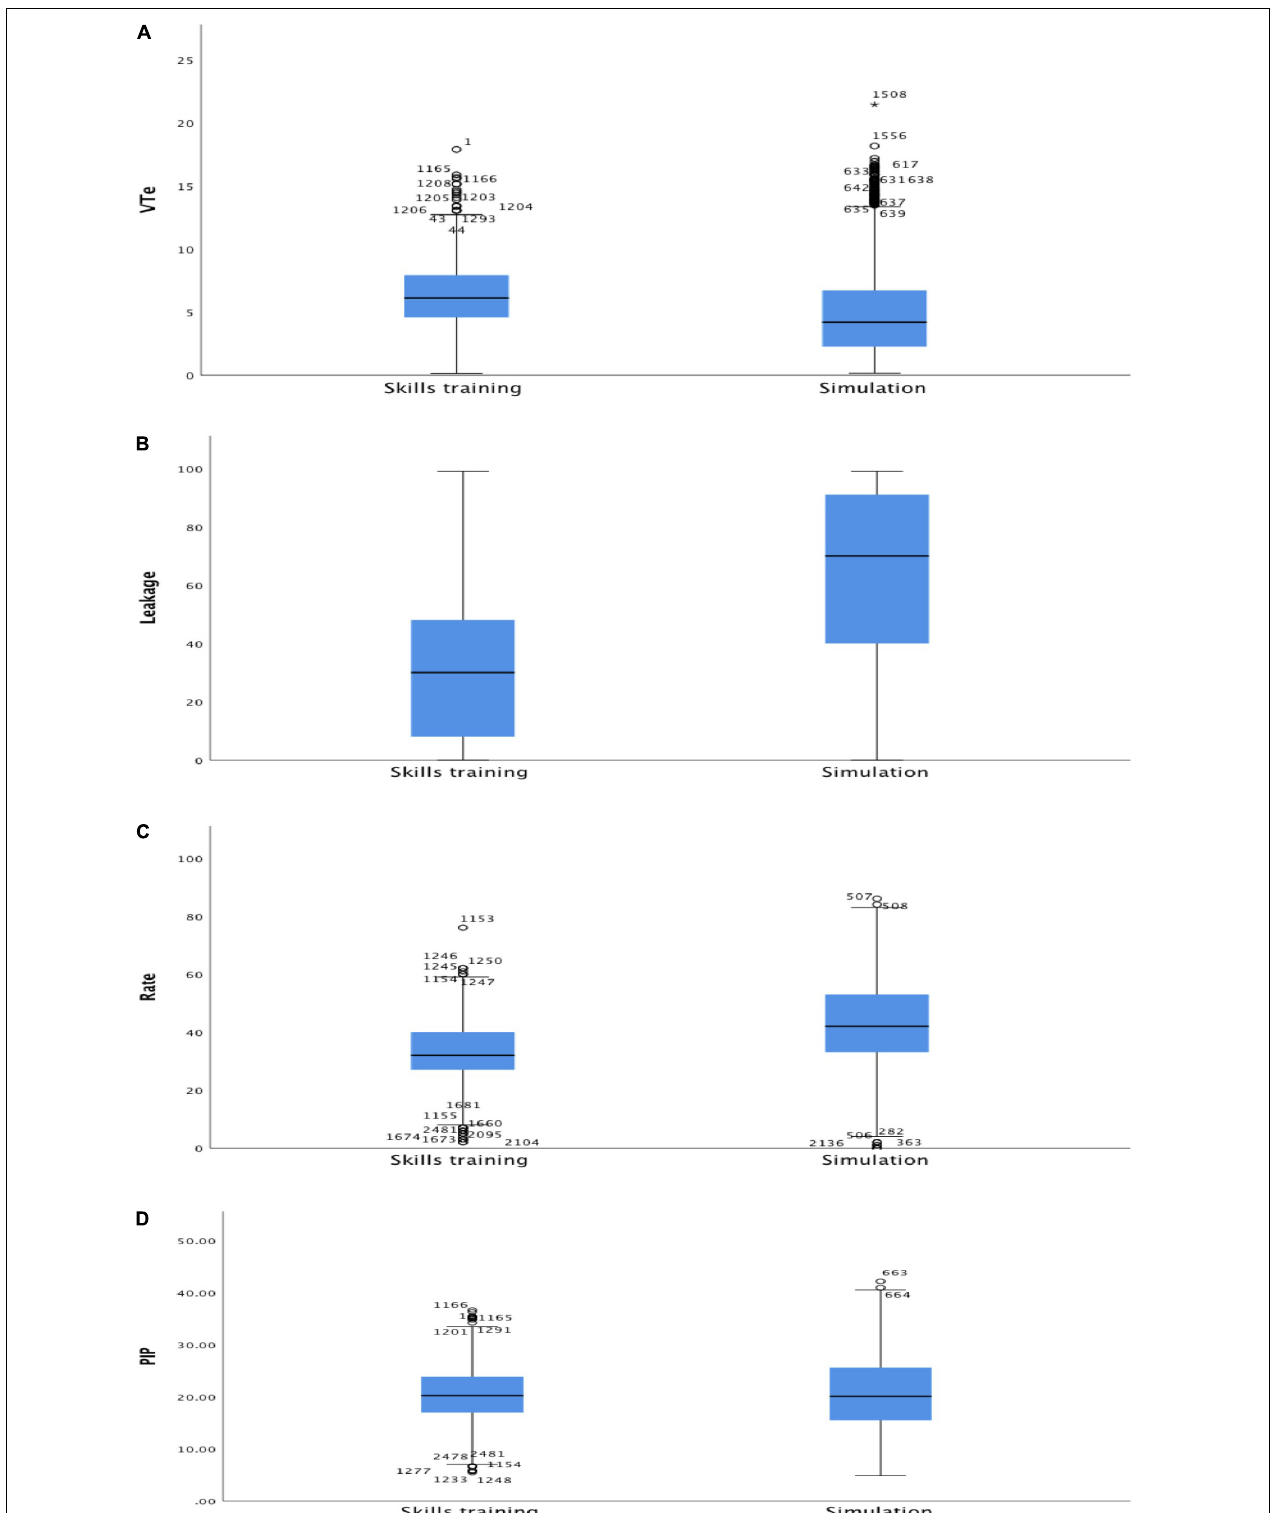
FIGURE 1 | Box plots all students combined of (A) expiratory tidal volume (VT e , ml/kg), (B) leakage (%), (C) ventilation rate (min − 1 ), and (D) positive inspiratory pressure (PIP, cmH 2 O) during skills and simulation training. Within each box, the horizontal black line represents the median value; boxes extend from the 25th to the 75th percentile; while the whiskers represent the minimum and maximum values,